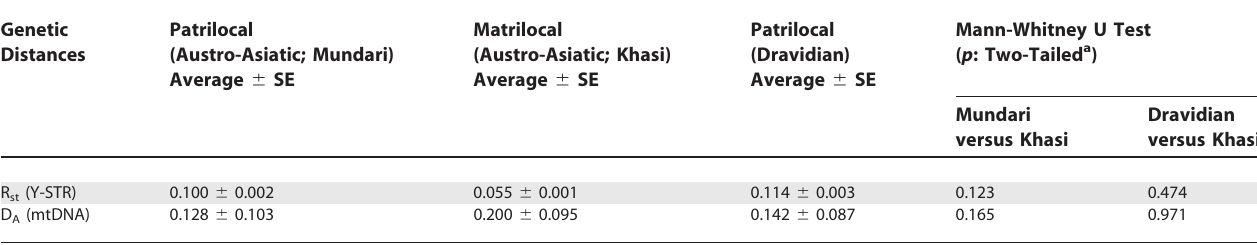
Table 1. Average Genetic Distance and Their Standard Error Based on mtDNA HVS1 and Y-STR among the Matrilocal and Patrilocal